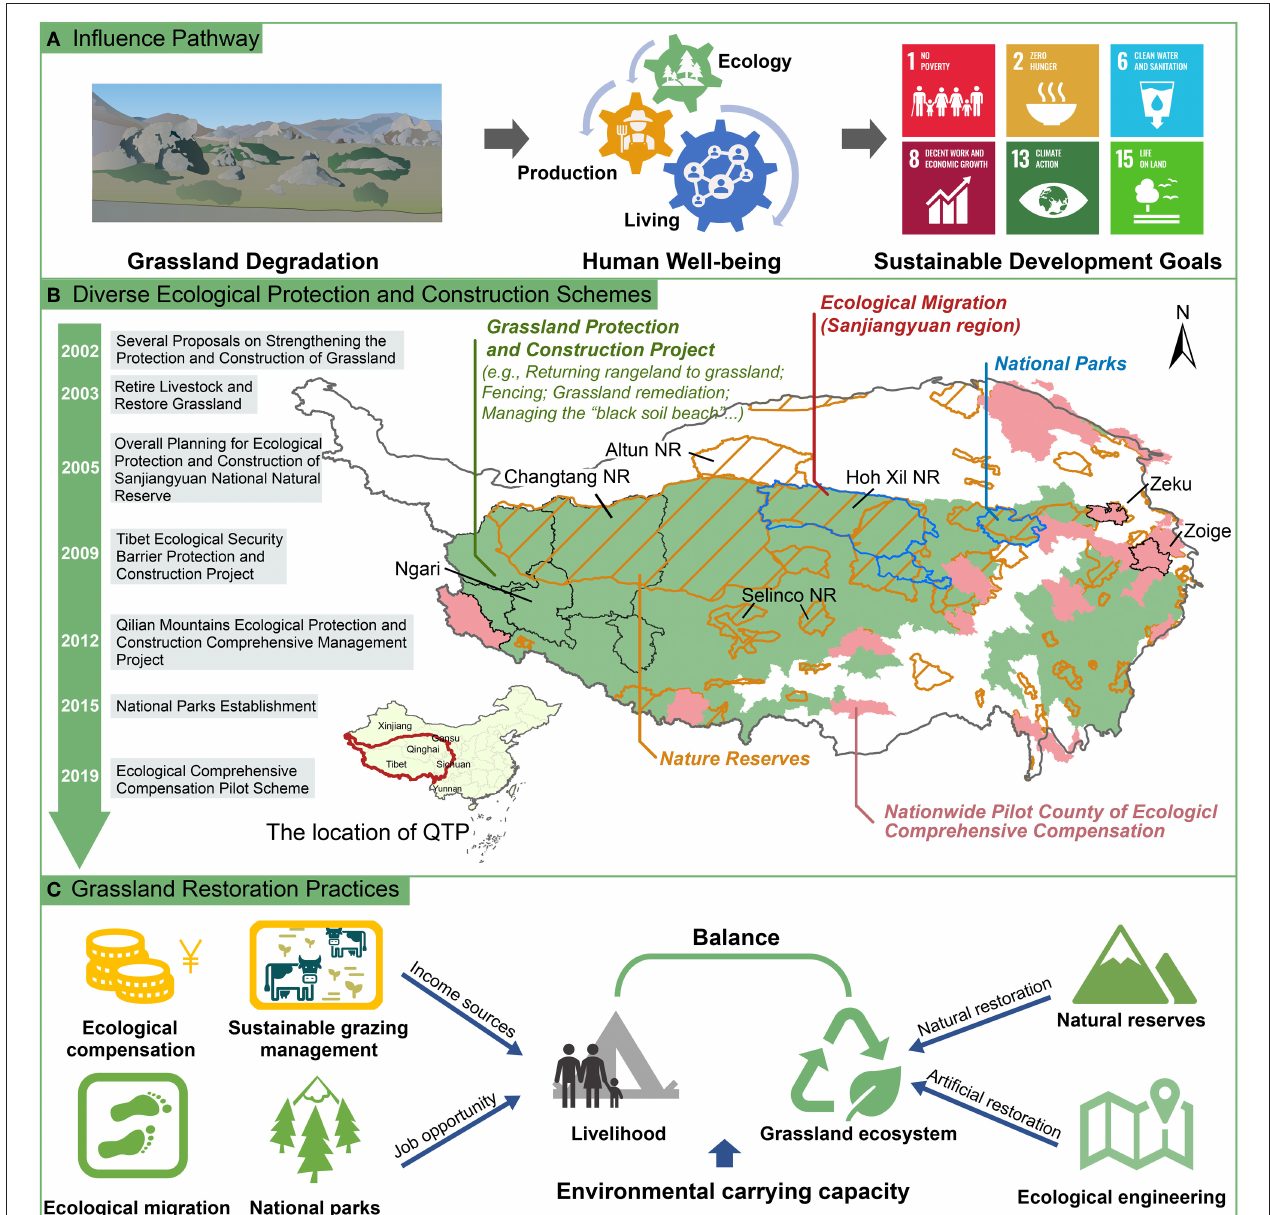
FIGURE 1 | Effects of grassland degradation and its restoration practices. (A) influence pathway of grassland degradation on human well-being and SDGs, (B) distribution and timeline of grassland ecological protection and construction schemes, and (C) potential implications for grassland ecosystem restoration. NR means nature